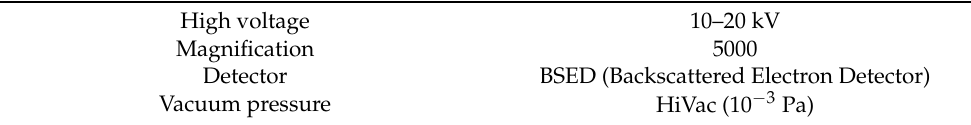
Table 3. Settings of the microscope FEI Quanta 650 FEG.